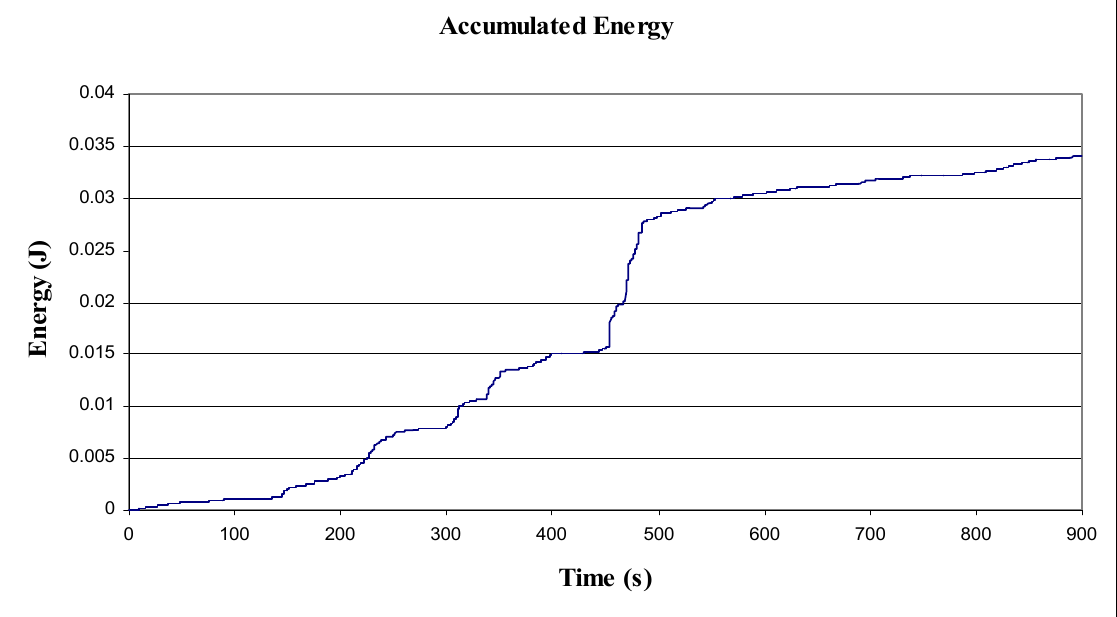
, from tree lean, for inertial mass 5 kg on 4 m long MOV